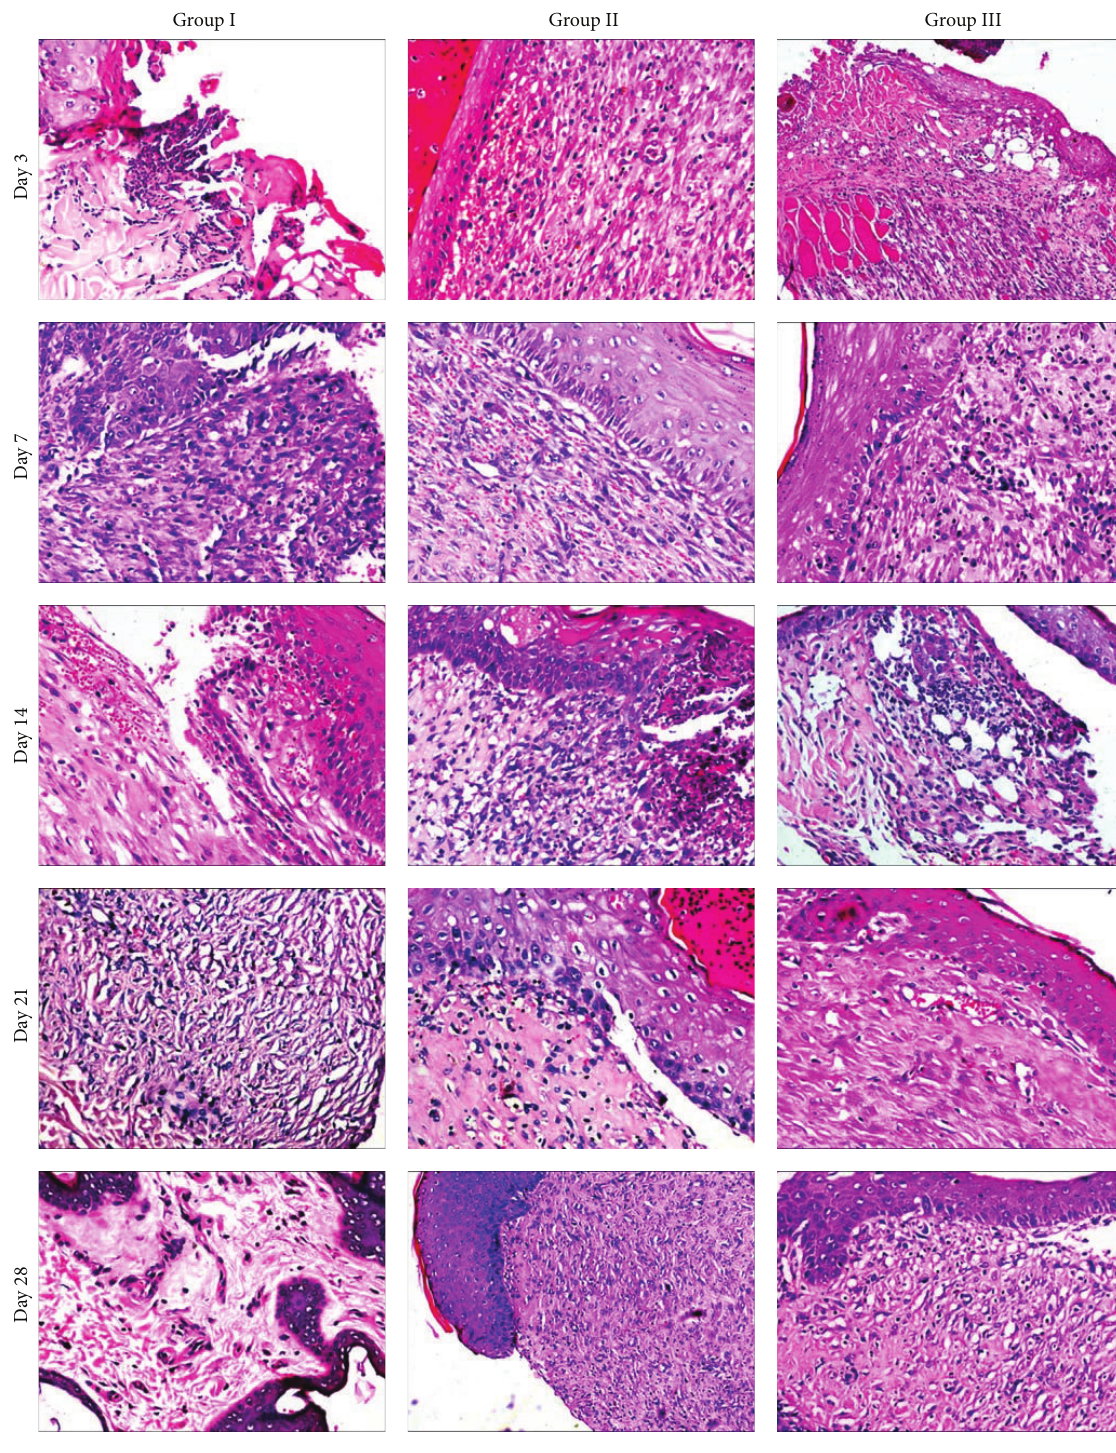
Figure 6: Microphotograph of different groups at different time intervals (H&E stain,